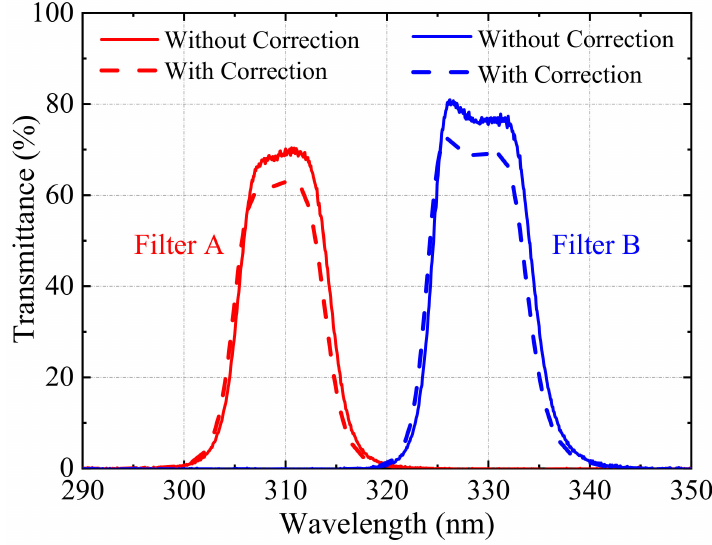
Figure 2. The transmittance curves of Filters A and B (solid lines) measured by the UV spectrometer, and the effective transmittance curves with non-vertical incidence correction (dotted